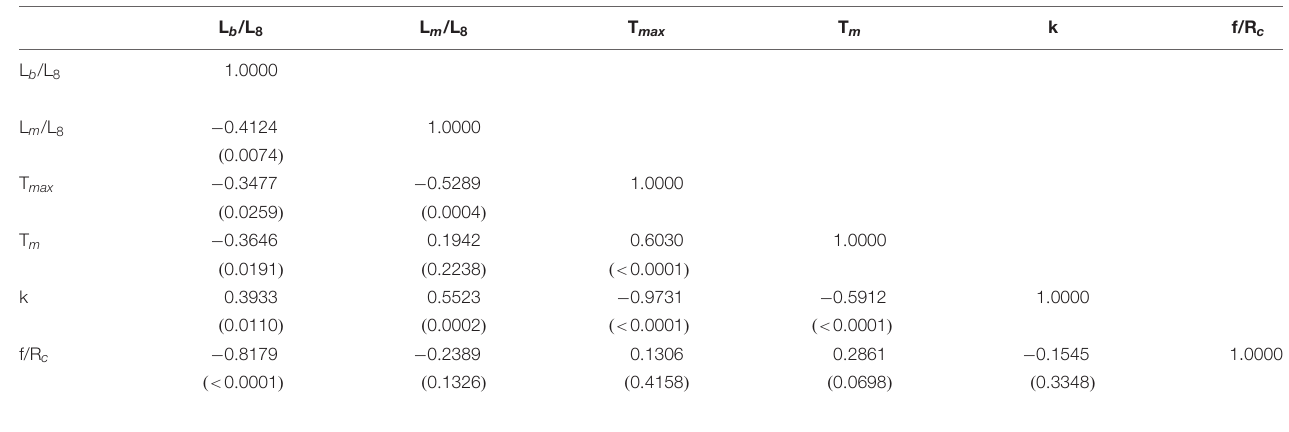
TABLE 2 | Correlation between life history parameters of skates and rays used in this study (parentheses indicate p -value). L b /L